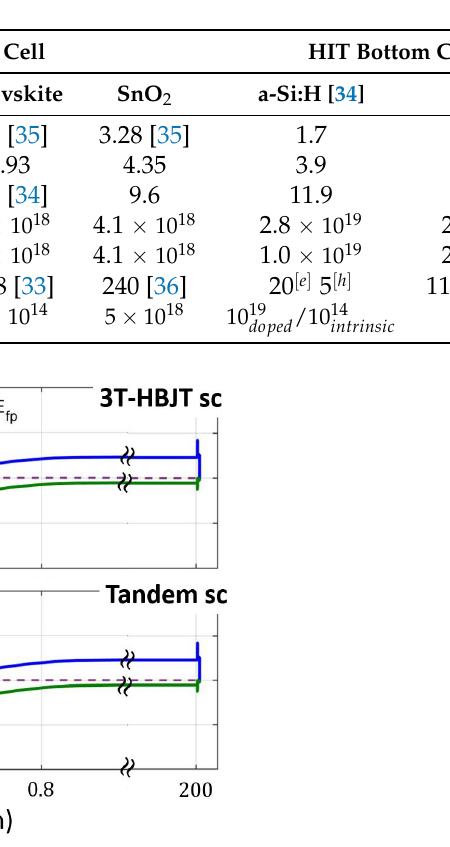
Figure 5. Energy band diagram of the 3T-HBT (top) and DJ (bottom) tandems under thermal equilibrium condition.